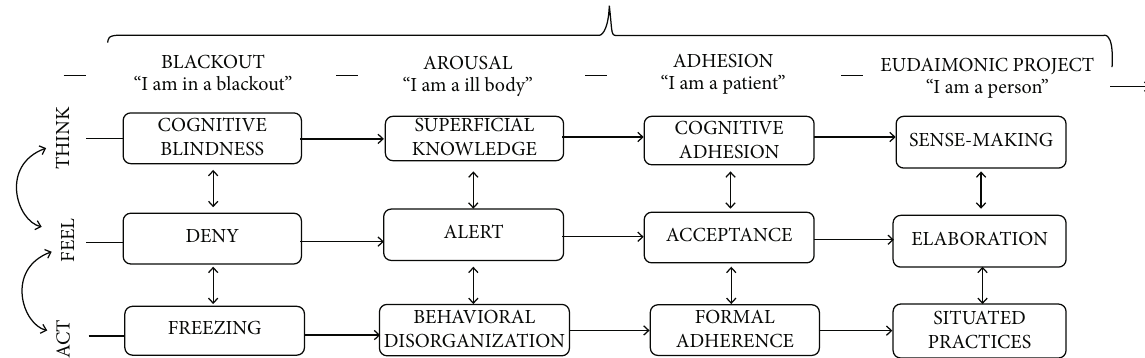
Figure 1: The Patient Health Engagement Model (PHE). Serena Barello, Guendalina Gra ffi gna